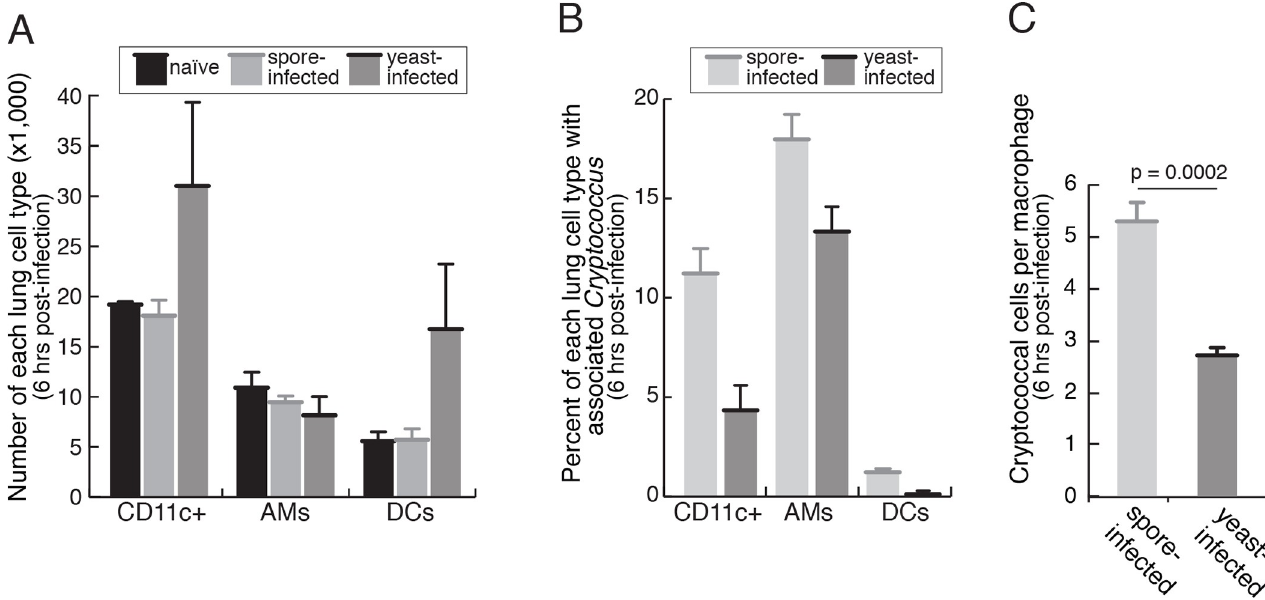
Fig 6. CD11c+ cells display more associated spores than yeast at 6 hours post-infection in the mouse lung. (A) The total number of each lung cell type (CD11c+, AMs = alveolar macrophages, DCs = dendritic cells) recovered at 6-hours post-infection in mice infected with PBS (“na ï ve," black bars, 2 mice), 5x10 6 mCherry-spores (light gray bars, 5 mice), or 5x10 6 mCherry yeast (dark gray bars, 5 mice). The results are expressed as bar plots illustrating the average ± SEM. For the number of DCs in spore- vs. yeast-infected mice p = 0.14. (B) Percent of each cell type (as identified in panel A) with associated mCherry+ Cryptococcus cells. The results are expressed as bar plots illustrating the average ± SEM. For the percentage of CD11c+ phagocytes associated with spores vs. yeast p = 0.019. (C) Cryptococcal cells per macrophage at 6 hours post-infection. Alveolar macrophages were recovered by bronchoalveolar lavage 6 hours post-infection in mice infected with 5x10 6 mCherry-spores (light gray bars, 3 mice), or 5x10 6 mCherry yeast (dark gray bars, 3 mice). The number of mCherry+ cryptococcal cells in 100 occupied macrophages was counted for each infected mouse. The results are expressed as the average occupancy of the three mice for each group ± SEM. For the number of spores vs. yeast per macrophage p = 0.0002 (by a Student’s t-test).